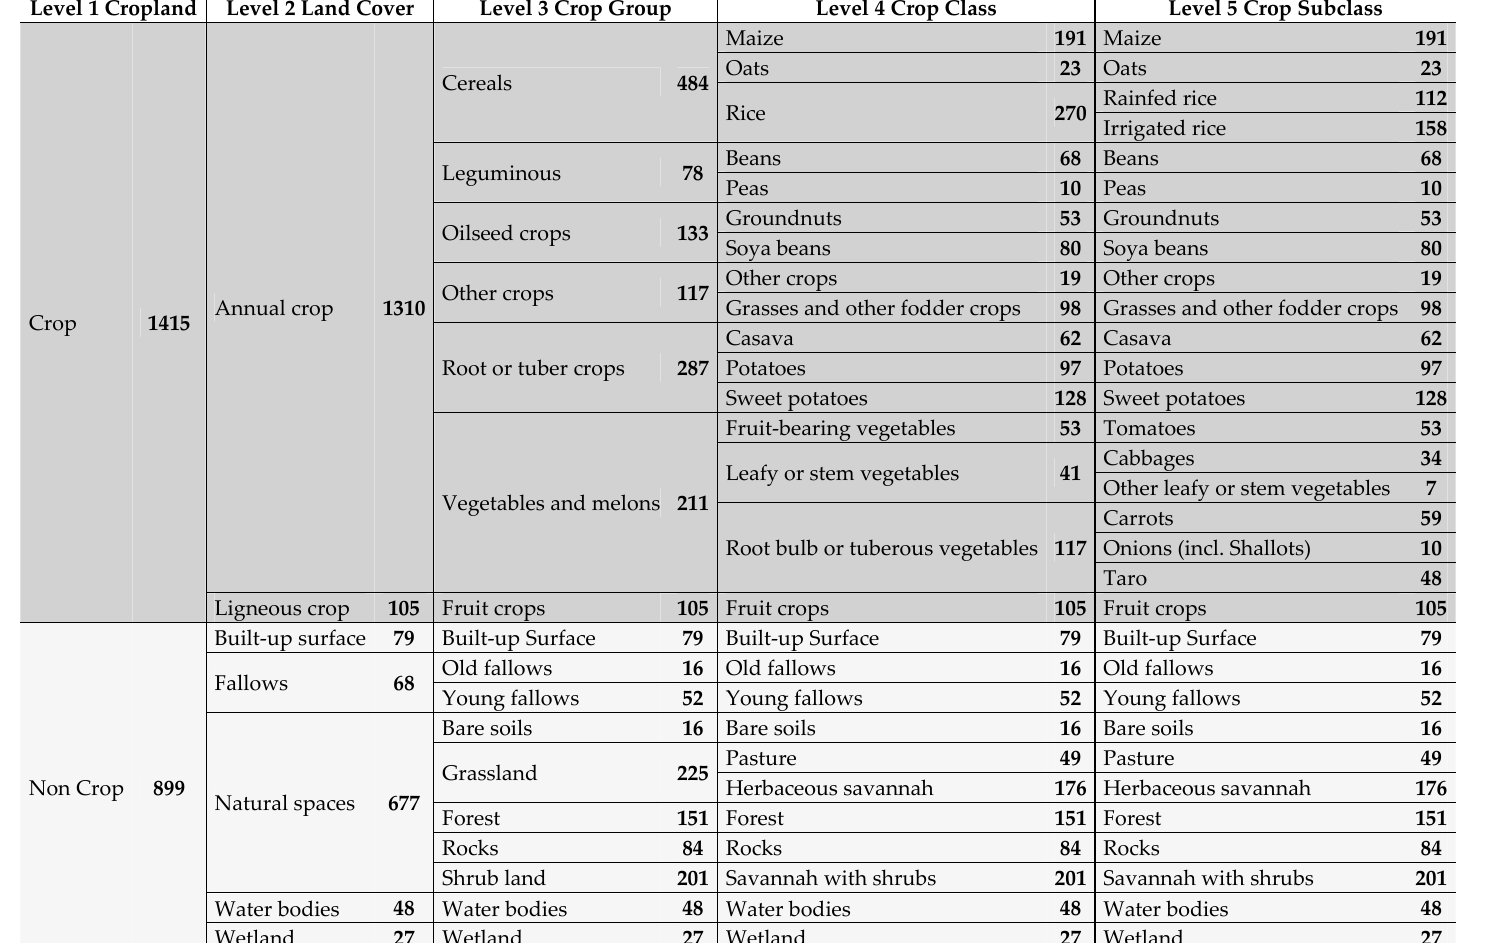
Table 1. Number of polygons per class in the learning database for each level of the JECAM (Joint Experiment for Crop Assessment and Monitoring) nomenclature (grey: cropped, light grey: